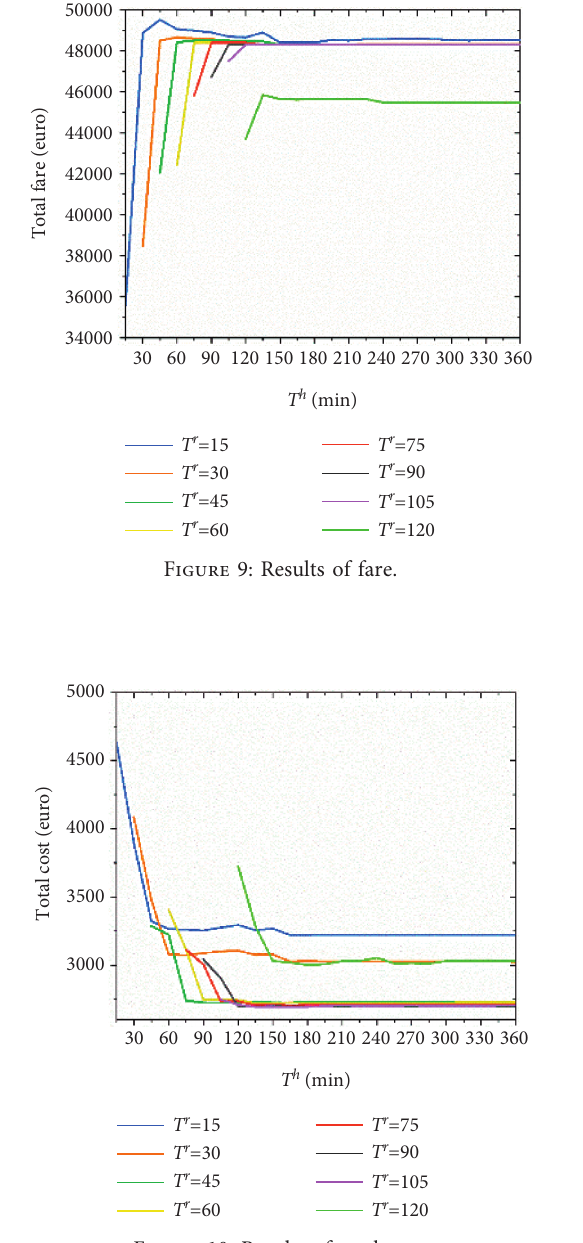
Figure 10: Results of total cost.